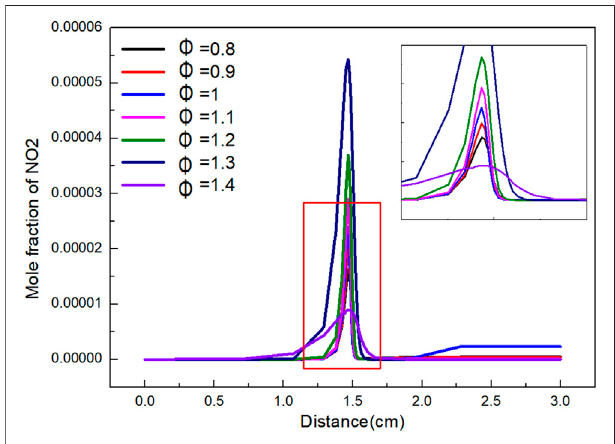
FIGURE 8 | Curve of NO mole fraction with distance under different Φ .